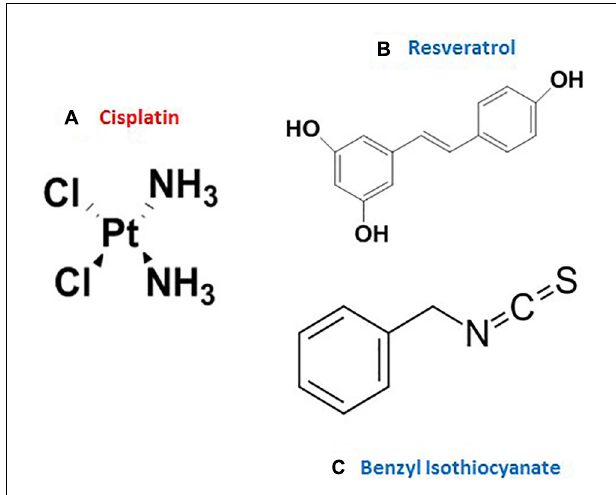
FIGURE 1 | The chemical structure of (A) cisplatin, (B) resveratrol, and (C) benzyl